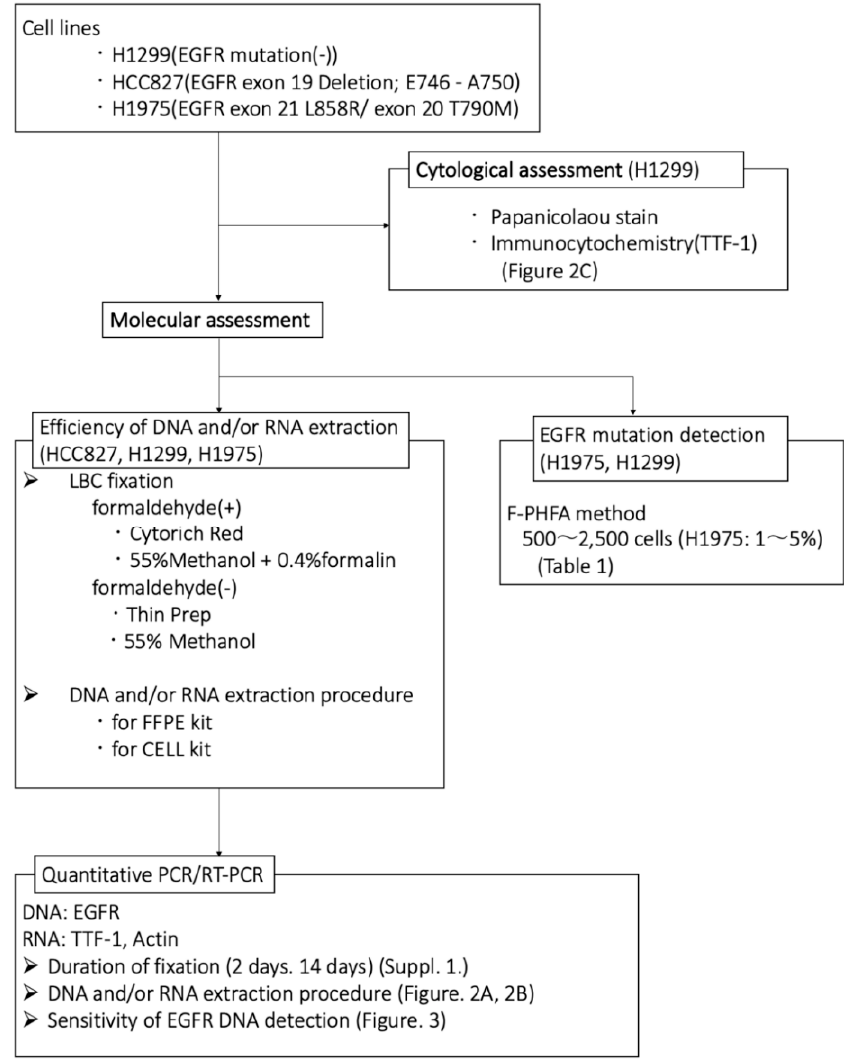
Figure 1. The scheme for DNA and RNA sample preparations using three adenocarcinoma cell lines. HCC827 and H1975 have epidermal growth factor receptor (EGFR) mutations.